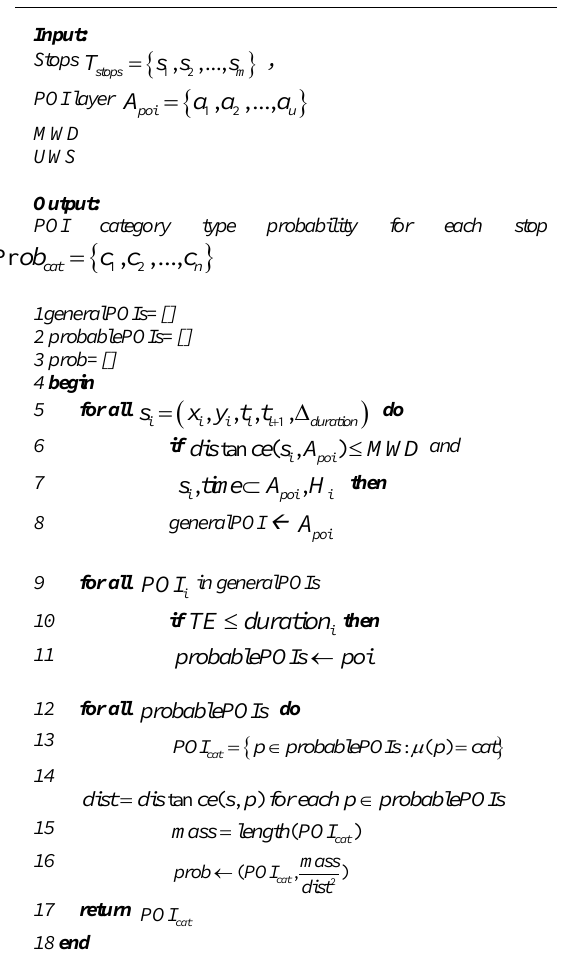
Algorithm 3. POI Type